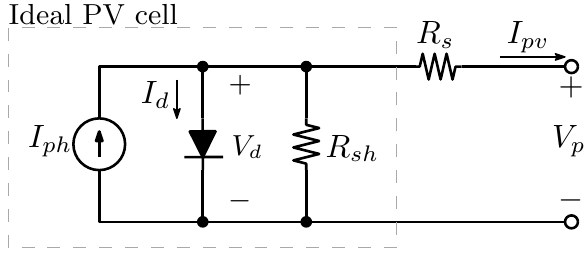
Figure 1. Single-diode equivalent circuit of a PV